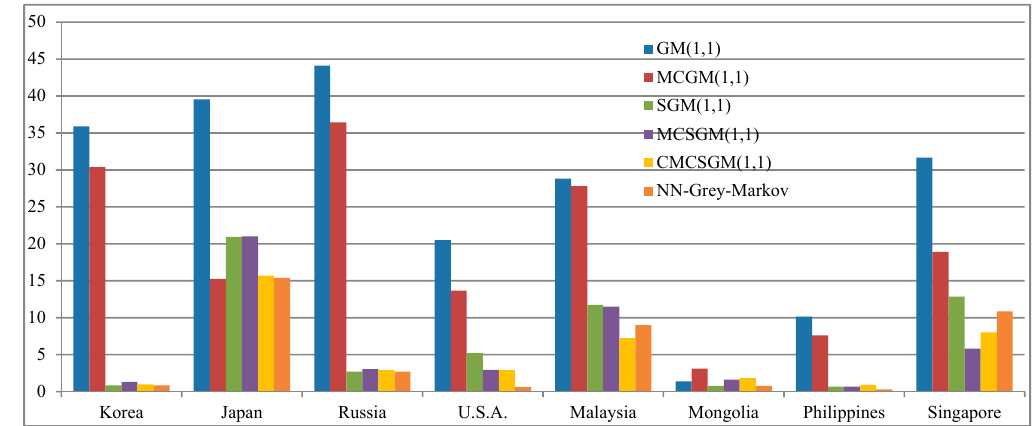
Figure 3. Model-fitting results for Case II.